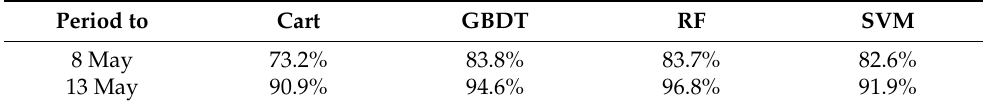
Table 16. Accuracy of rice identification in 2020 different periods.